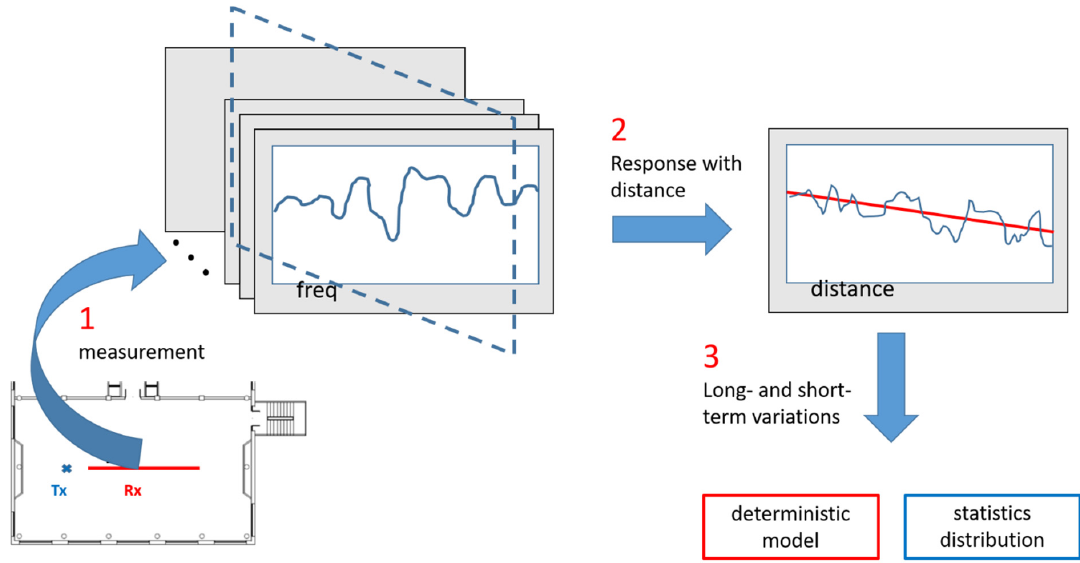
Figure 4. Scheme of data processing.